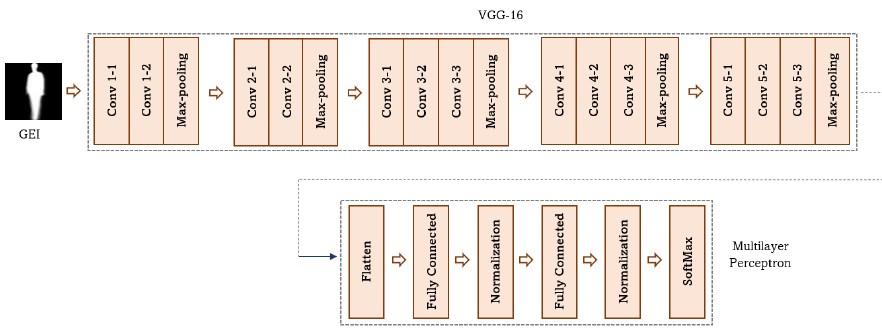
Figure 4. Architecture of the VGG-16 with the Multilayer Perceptron